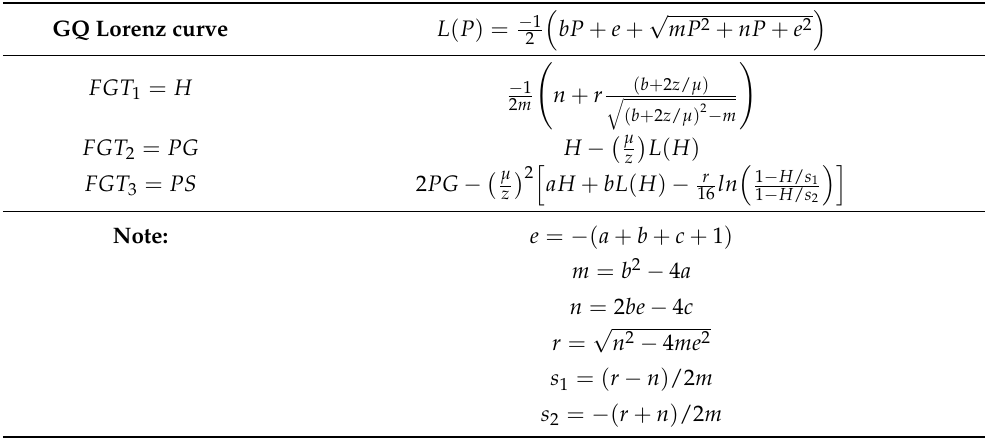
Table 1. FGT indices derived from the parameterized GQ Lorenz